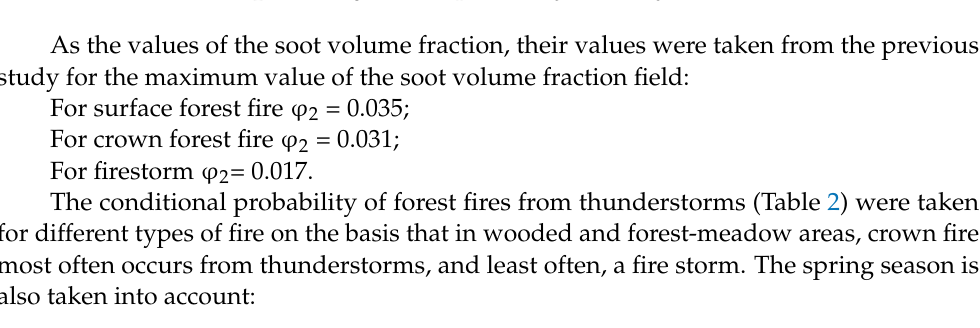
Table 2. Probability of a forest fire from thunderstorm activity, taking into account the influence of soot particles on the formation of a thunderstorm front in the spring for scenario